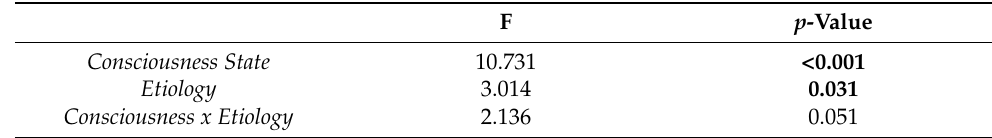
Table 2. Generalized linear model with ApEN as response variable.